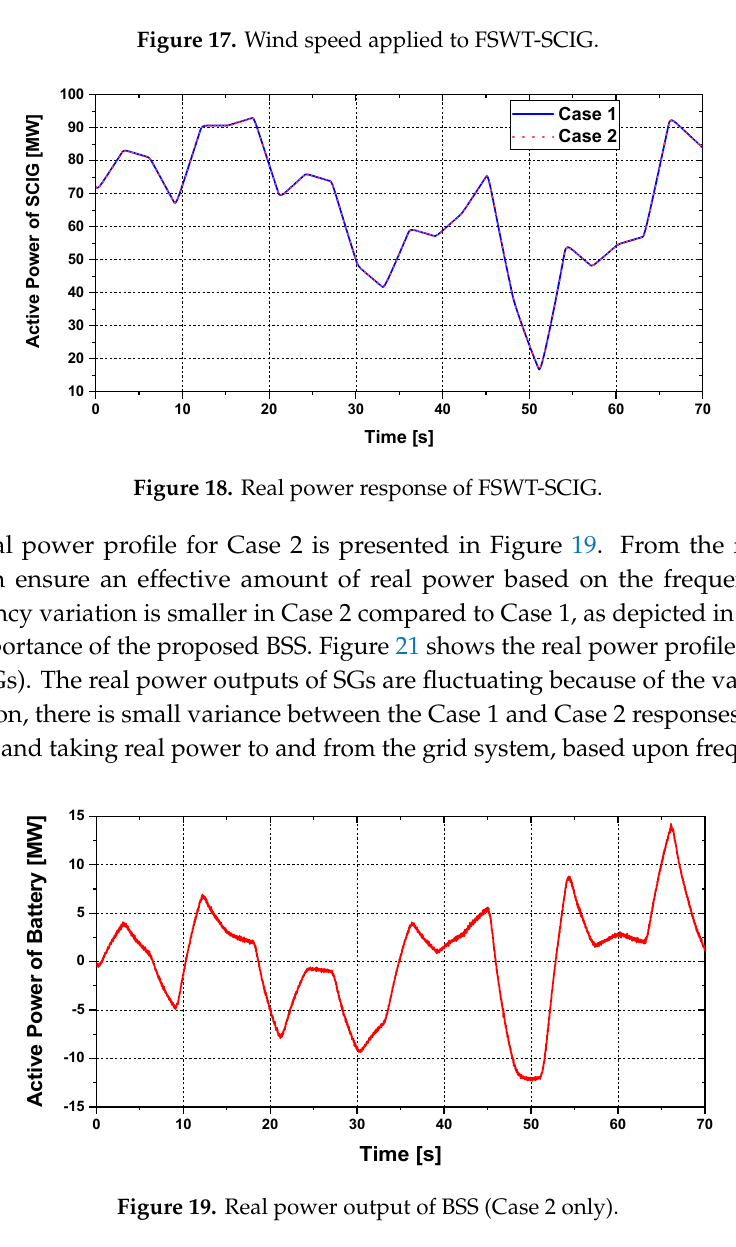
Figure 19. Real power output of BSS (Case 2 only).